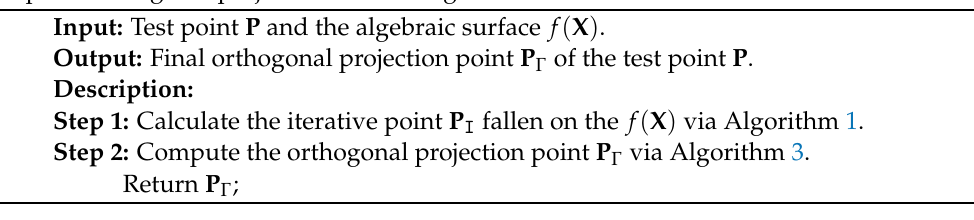
Algorithm 5: The simplified version hybrid geometry strategy algorithm for point orthogonal projection onto an algebraic surface.